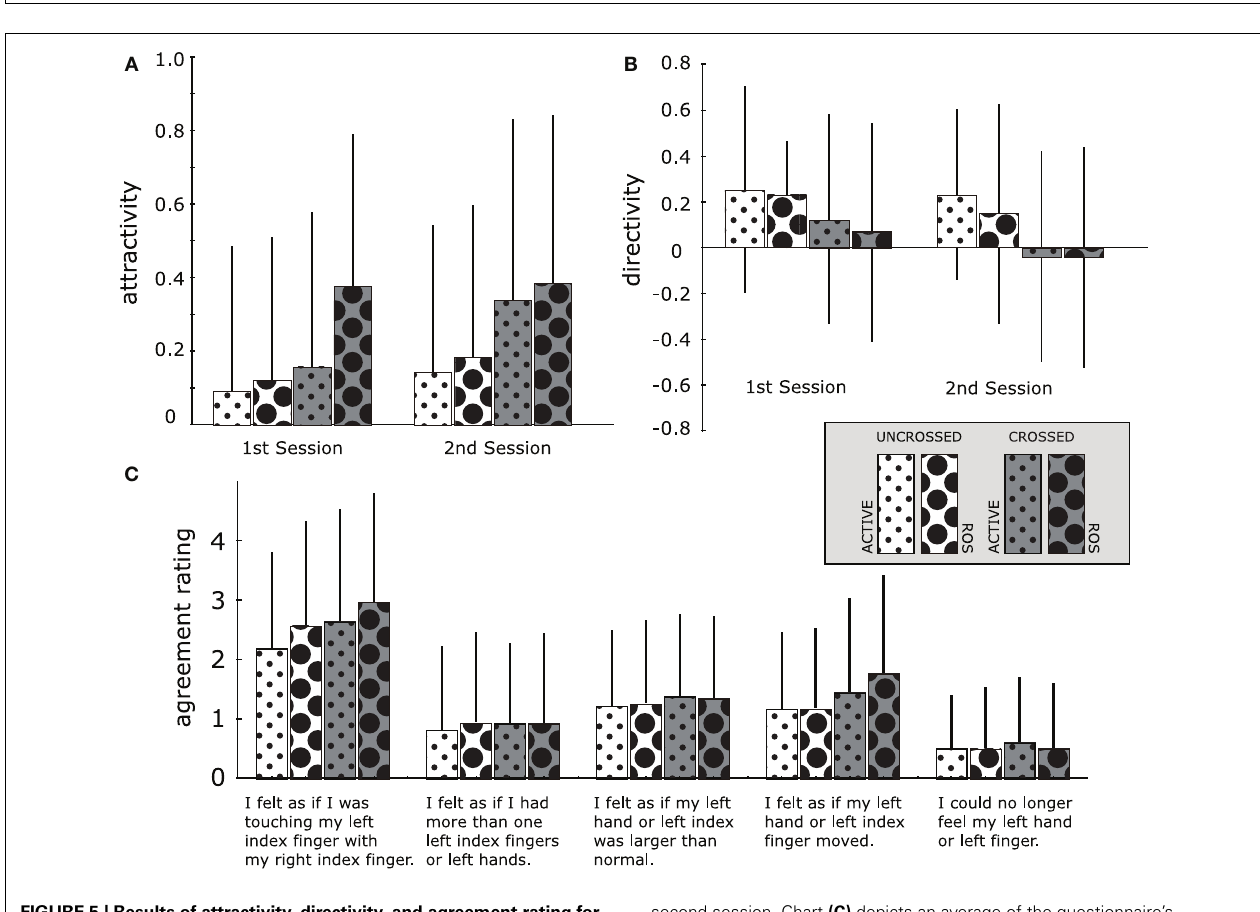
balance of the attraction, focusing on the difference between the two types of proprioceptive drifts (PDs), whose sign is positive/negative if the PD of the administrating hand is larger/smaller than that of the receptive hand.